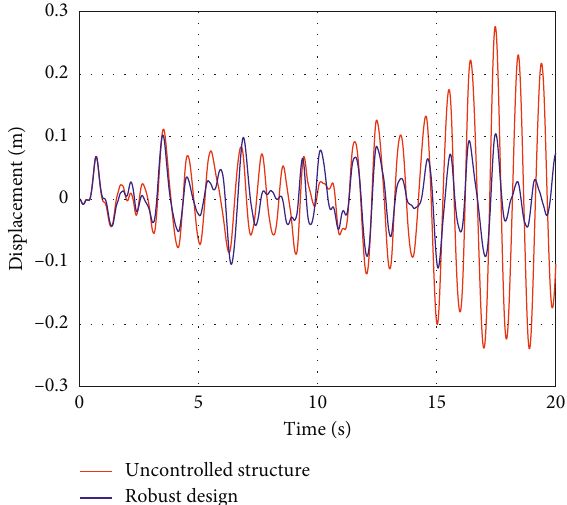
Figure 5: Displacement at top of the structure for uncontrolled structure (red curve) and controlled structure (blue curve).